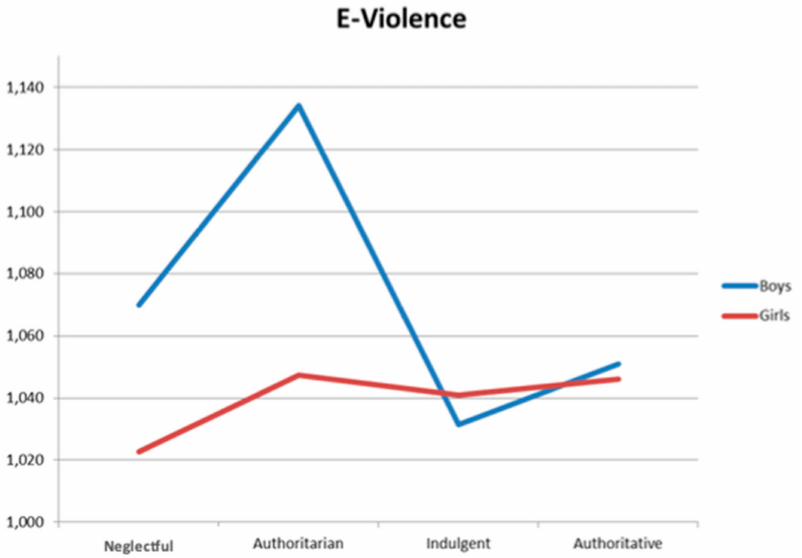
Figure 1. Iteration e ff ect on e-violence of the mother´s